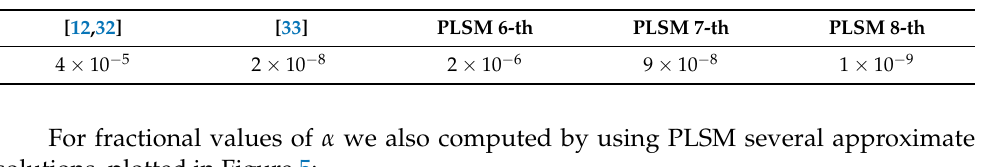
Table 5. Comparison of the order of the absolute errors of the approximate solutions for problem (26) corresponding to α = 4.